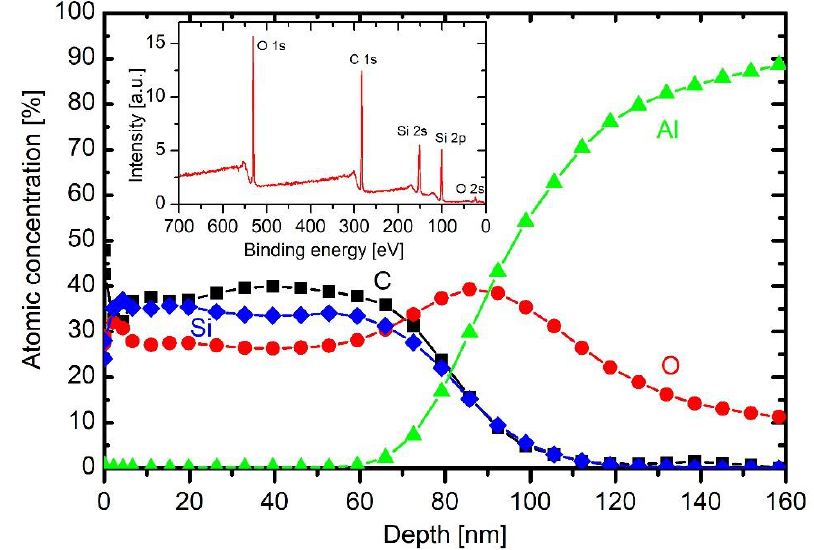
Figure 9. XPS depth profile of a sample exposed to plasma of 10 Pa HMDSO and 2.5 Pa O 2 for 30 s at 200 W, with inserted wide energy range XPS spectrum obtained on the surface of this sample.